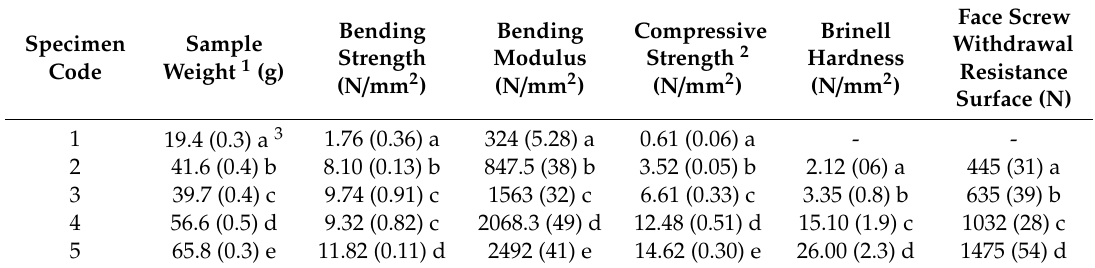
Table 2. Mechanical properties of the specimens with a gyroid-structure